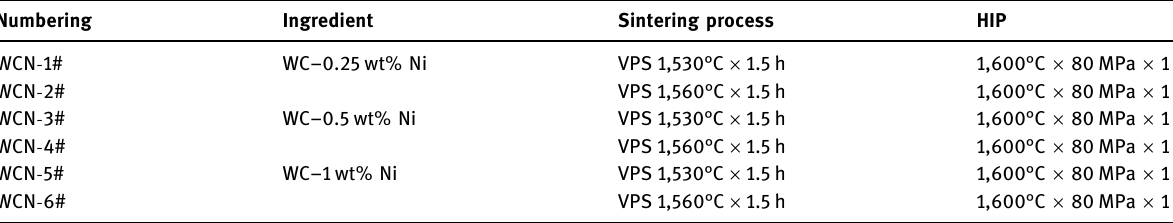
Table 2: WC – Ni composite ceramics sintering